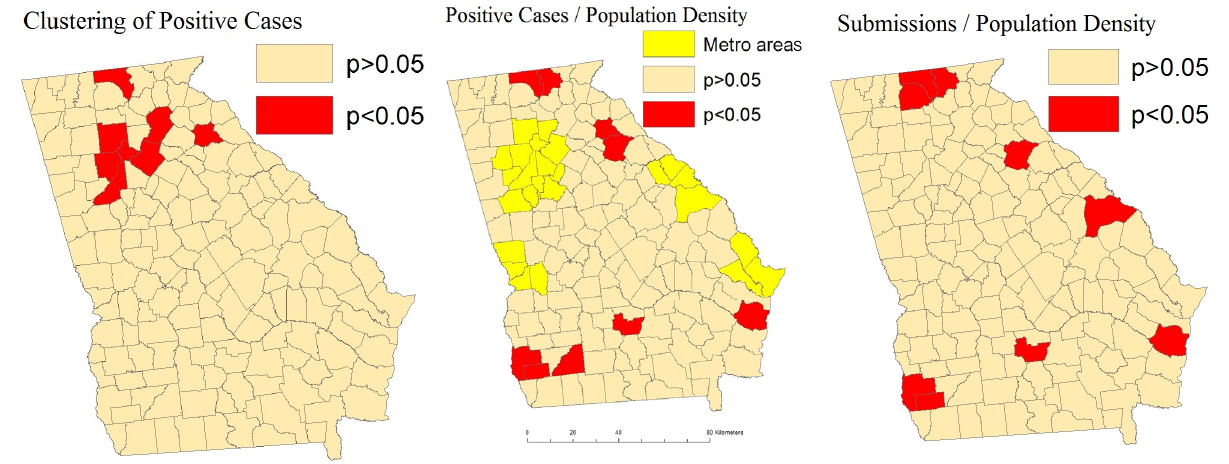
Figure 4. Significant clustering of positive cases occurs mostly in the metro Atlanta area where there are also high submission rates. The clustering of positive cases is mostly away from major population centers when analyzed as a rate of population density. Clustering of submissions/density closely parallels positive